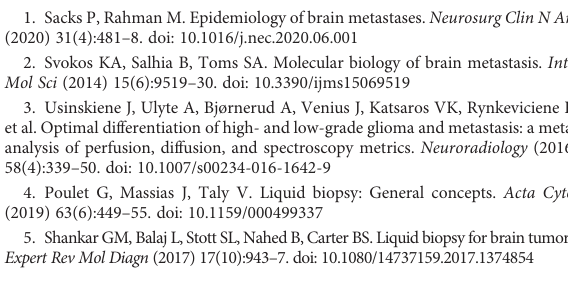
SUPPLEMENTARY FIGURE 1 The positive likelihood ratio of CSF liquid biopsy for LM diagnosis SUPPLEMENTARY FIGURE 2 The negative likelihood ratio of CSF liquid biopsy for diagnosis of LM. SUPPLEMENTARY FIGURE 3 Diagnostic odds ratios for the diagnosis of LM by CSF liquid